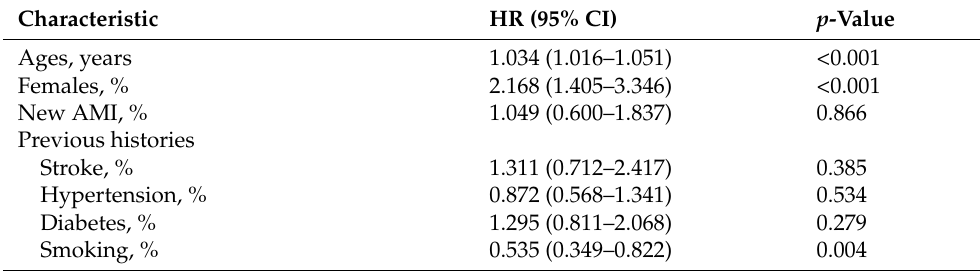
Table 2. Univariable Cox regression analysis for MACE in Patients with